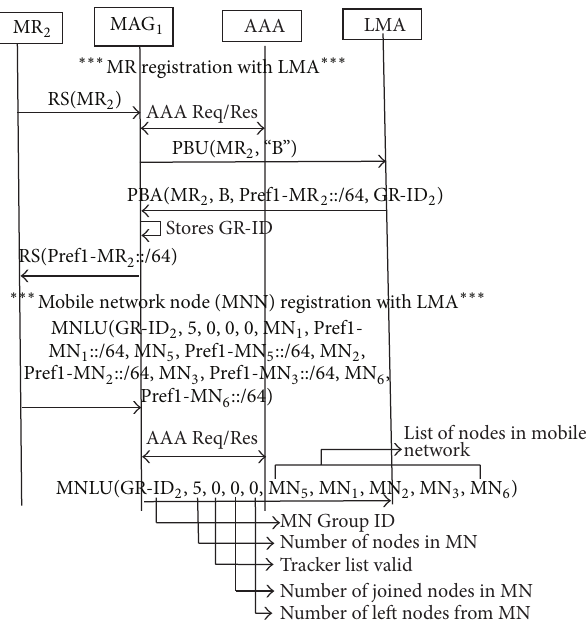
Figure 7: Message flow while mobile network changes its MAG.